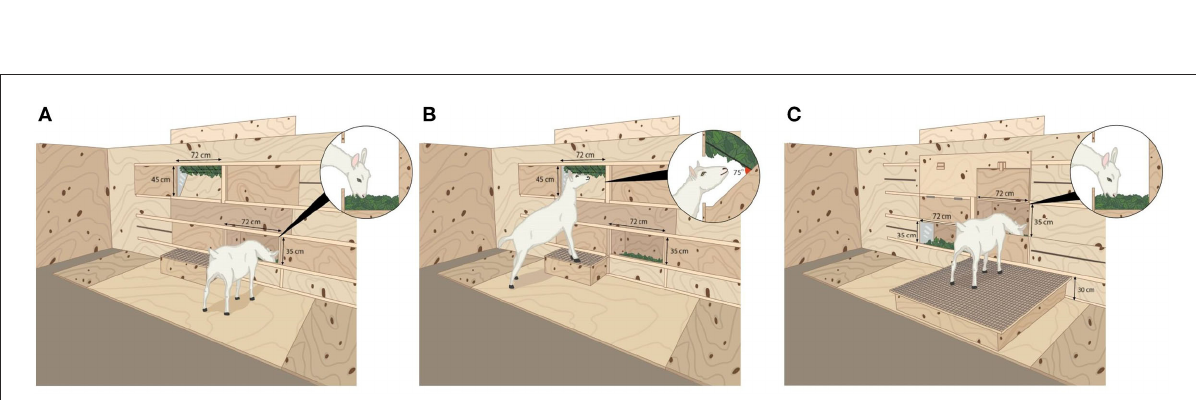
FIGURE2 Detailed drawings of the three different feeding settings. (A) Floor-level feeder: head of the goat lowered during feeding, ground-oriented, to mimic grazing. (B) Elevated feeder: the head and the body of the goat were pointing upwards with two front hooves on a step (25 or 30cm height) to mimic browsing. The step was covered with a mesh to prevent slipping. (C) Platform-level feeder identical to the floor-level feeder, but accessible by putting all four hooves on a platform (30cm height). Head of the goat was lowered during feeding, ground-oriented, to mimic grazing. The platform was covered with a mesh to prevent slipping. Settings A and B were used in Exp1, while settings A and C were used in